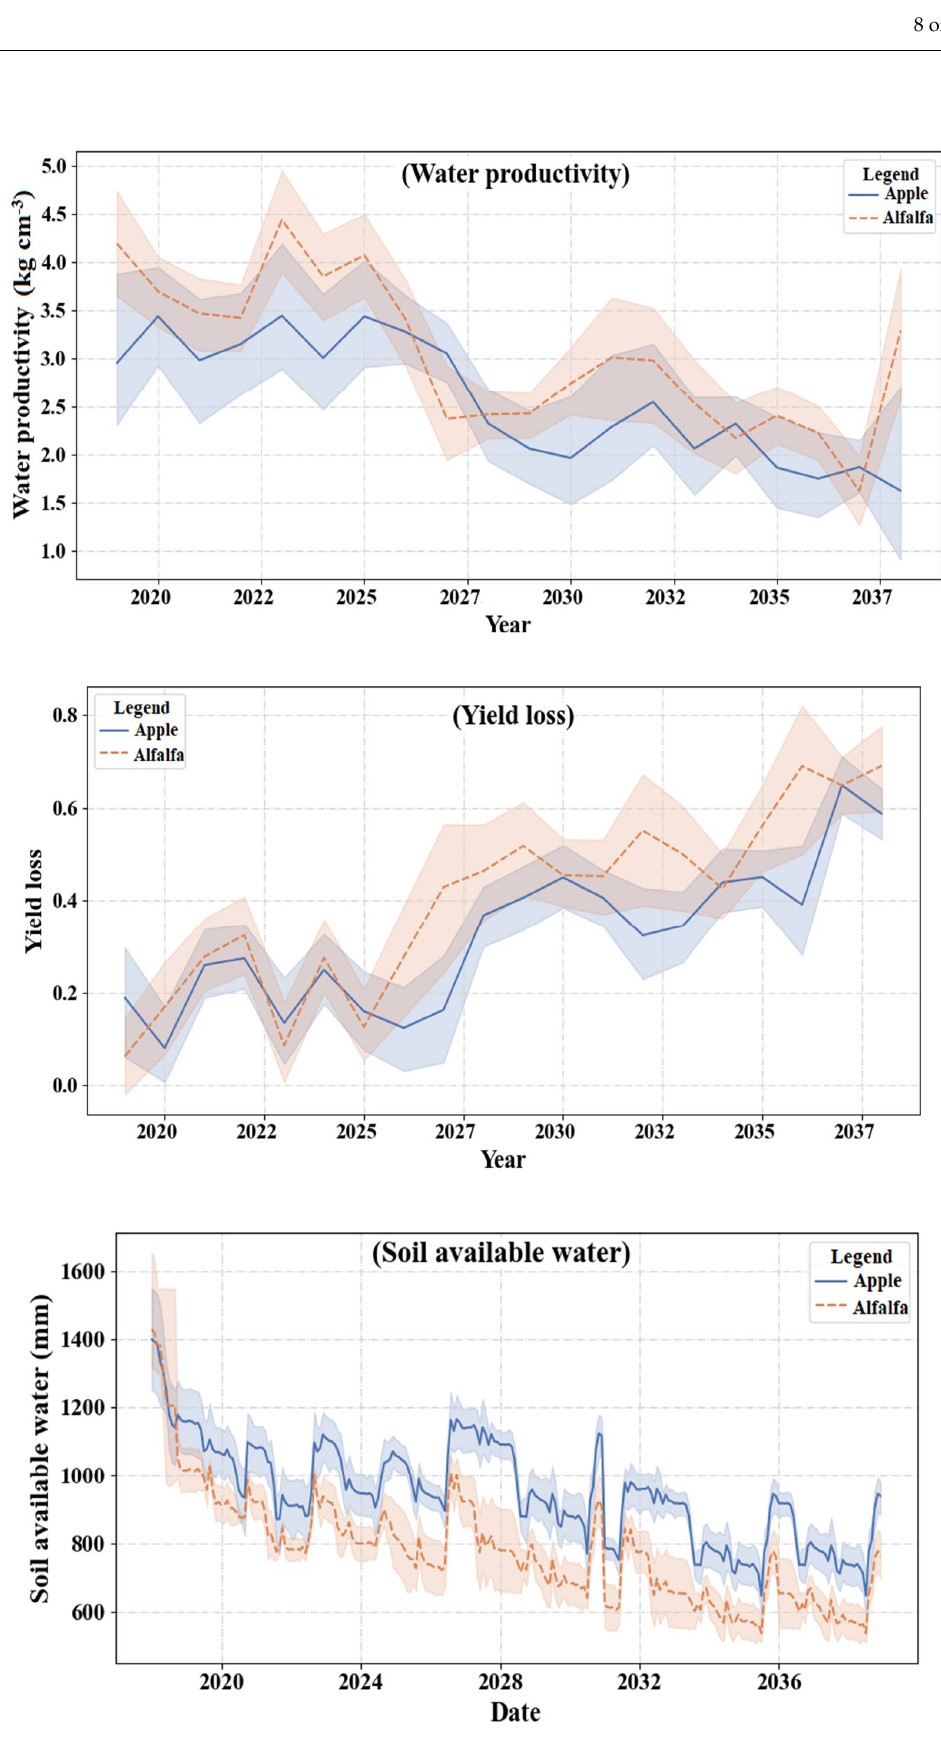
Figure 6. Prediction of water productivity, yield loss, and soil available water for apple and alfalfa from 2019 to 2038.